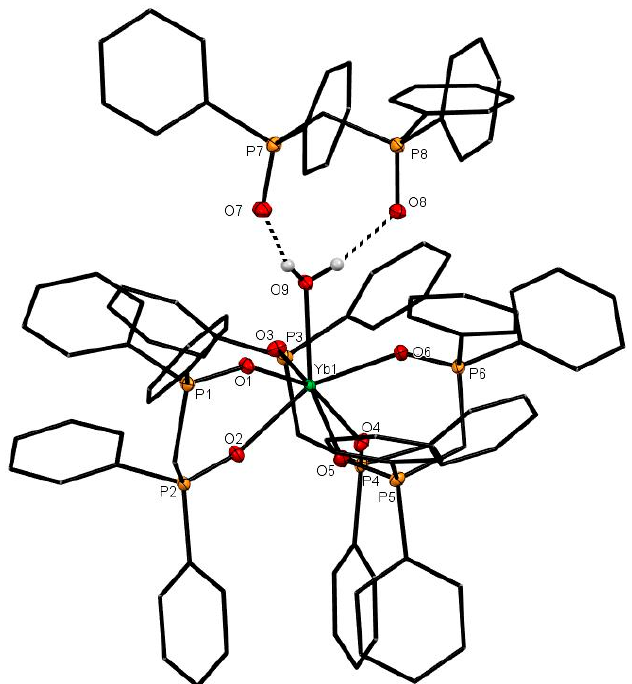
Figure 7. The cation in [Yb(dppmO 2 ) 3 (H 2 O)]Cl 3 · dppmO 2 · 12H 2 O also showing the hydrogen-bonded dppmO 2 molecule. Selected bond lengths (Å): Yb1–O3 = 2.2341(14), Yb1–O2 = 2.2899(13), Yb1–O9 = 2.3263(14), Yb1–O4 = 2.2683(13), Yb1–O6 = 2.2208(13), Yb1–O1 = 2.2328(13), Yb1–O5 = 2.2696(14), P n –O n ( n = 1–6) = 1.5034(14)–1.5072(14), P7–O7 = 1.4924(15), P8–O8 = 1.4926(15).